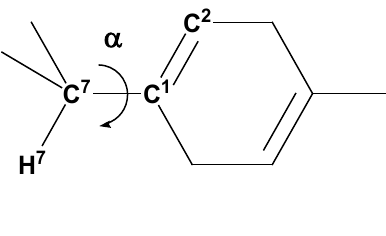
Figure 1. Conformers of 1-isopropyl-4-methyl-1,4-cyclohexadiene resulting from the rotation about the C 7 –C 1 bond, adapted from